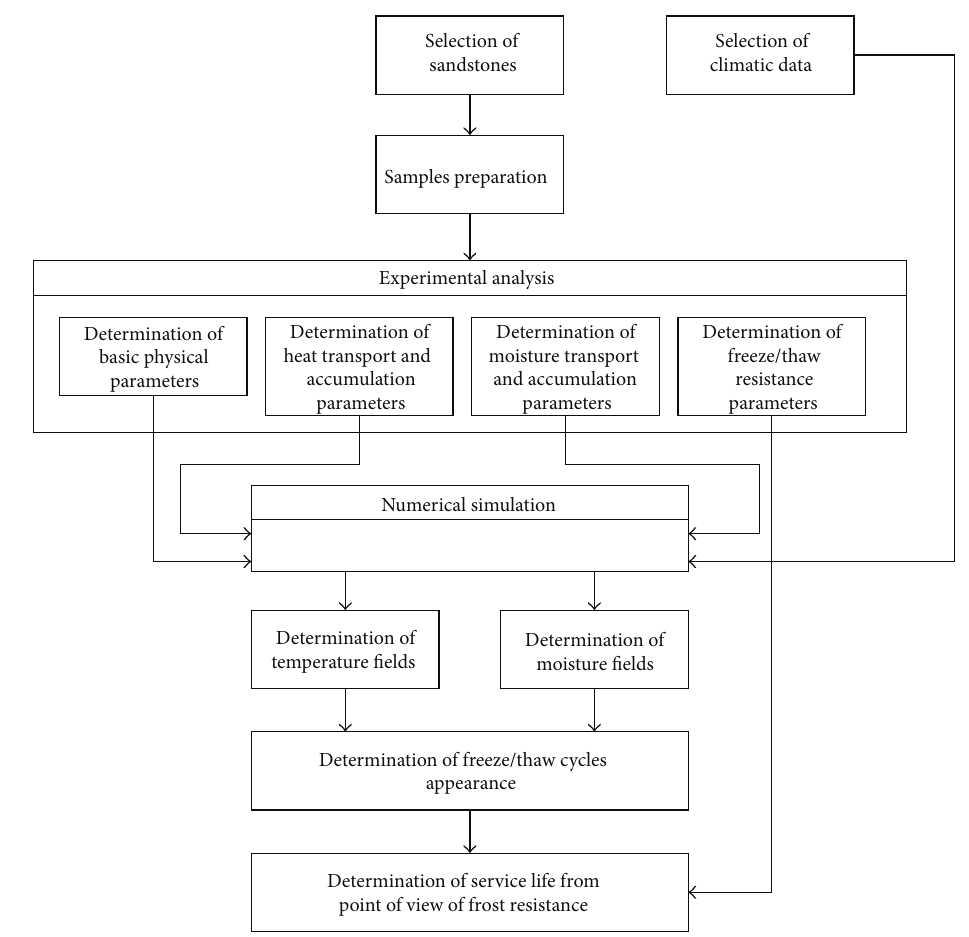
Figure 5: Flowchart of the service life assessment process.